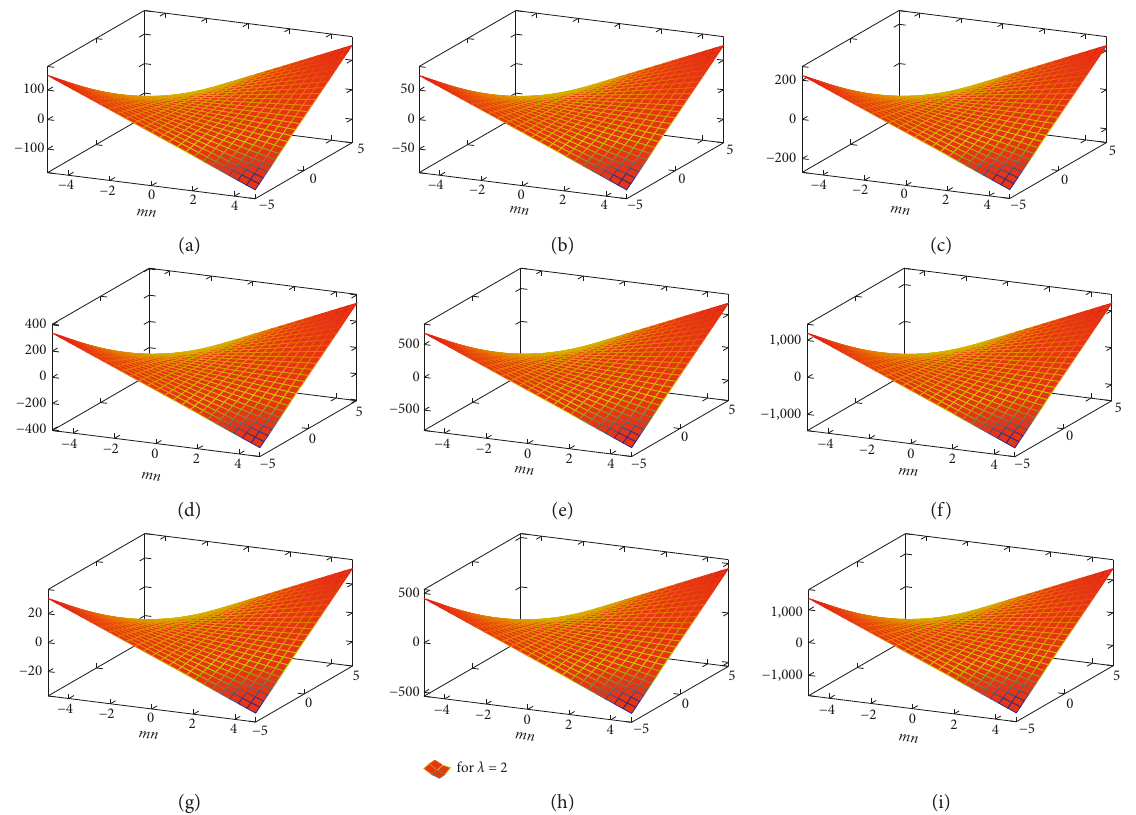
Figure 3: The plot of topological indices. (a) Reduced reciprocal randic index. (b) Arithmetic geometric index. (c) SK index. (d) SK